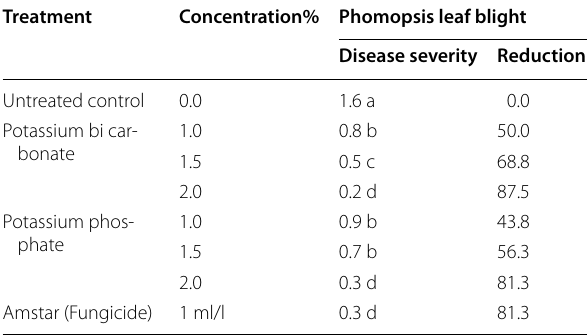
Values with the same letter are not significantly different ( P